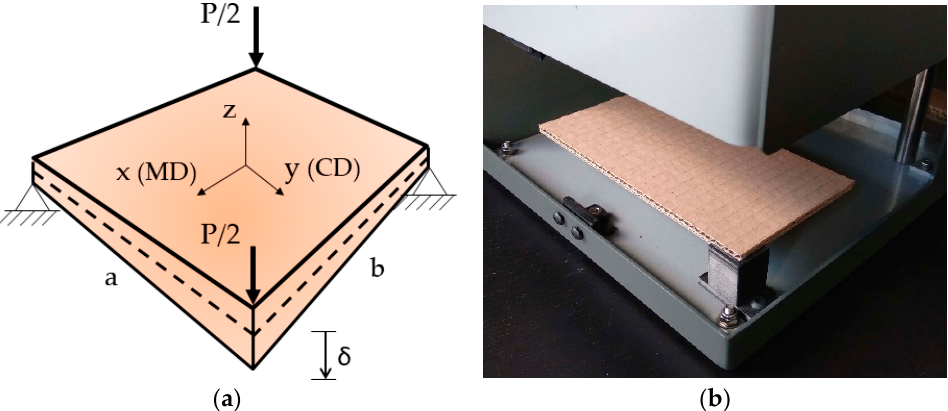
Figure 1. ( a ) Scheme of the static plate torsion test; ( b ) visualization of the sample in the machine during test.